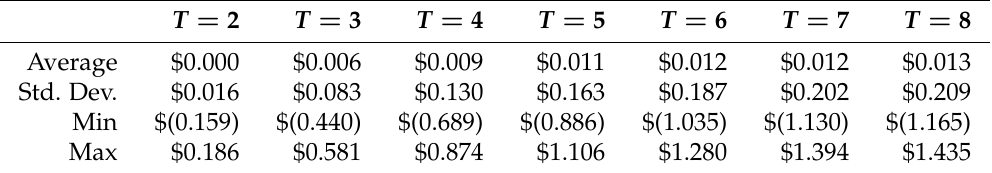
Table 5. Tracking error for option